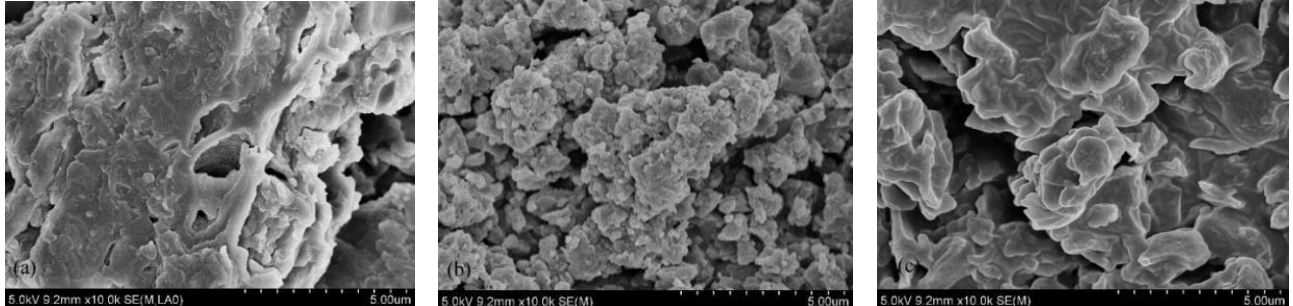
Figure 3. Scanning topography of SEM ( a ): before modification, ( b ): FMPAs, ( c ): FMPAs after adsorption of Sb( III ). Table 7. The elemental composition ( w / w %) of FMPAs before modification, and FMPAs after adsorption with Sb(III). Element C-K N-K O-K Na-K FMPAs before modification FMPAs FMPAs + Sb(III)